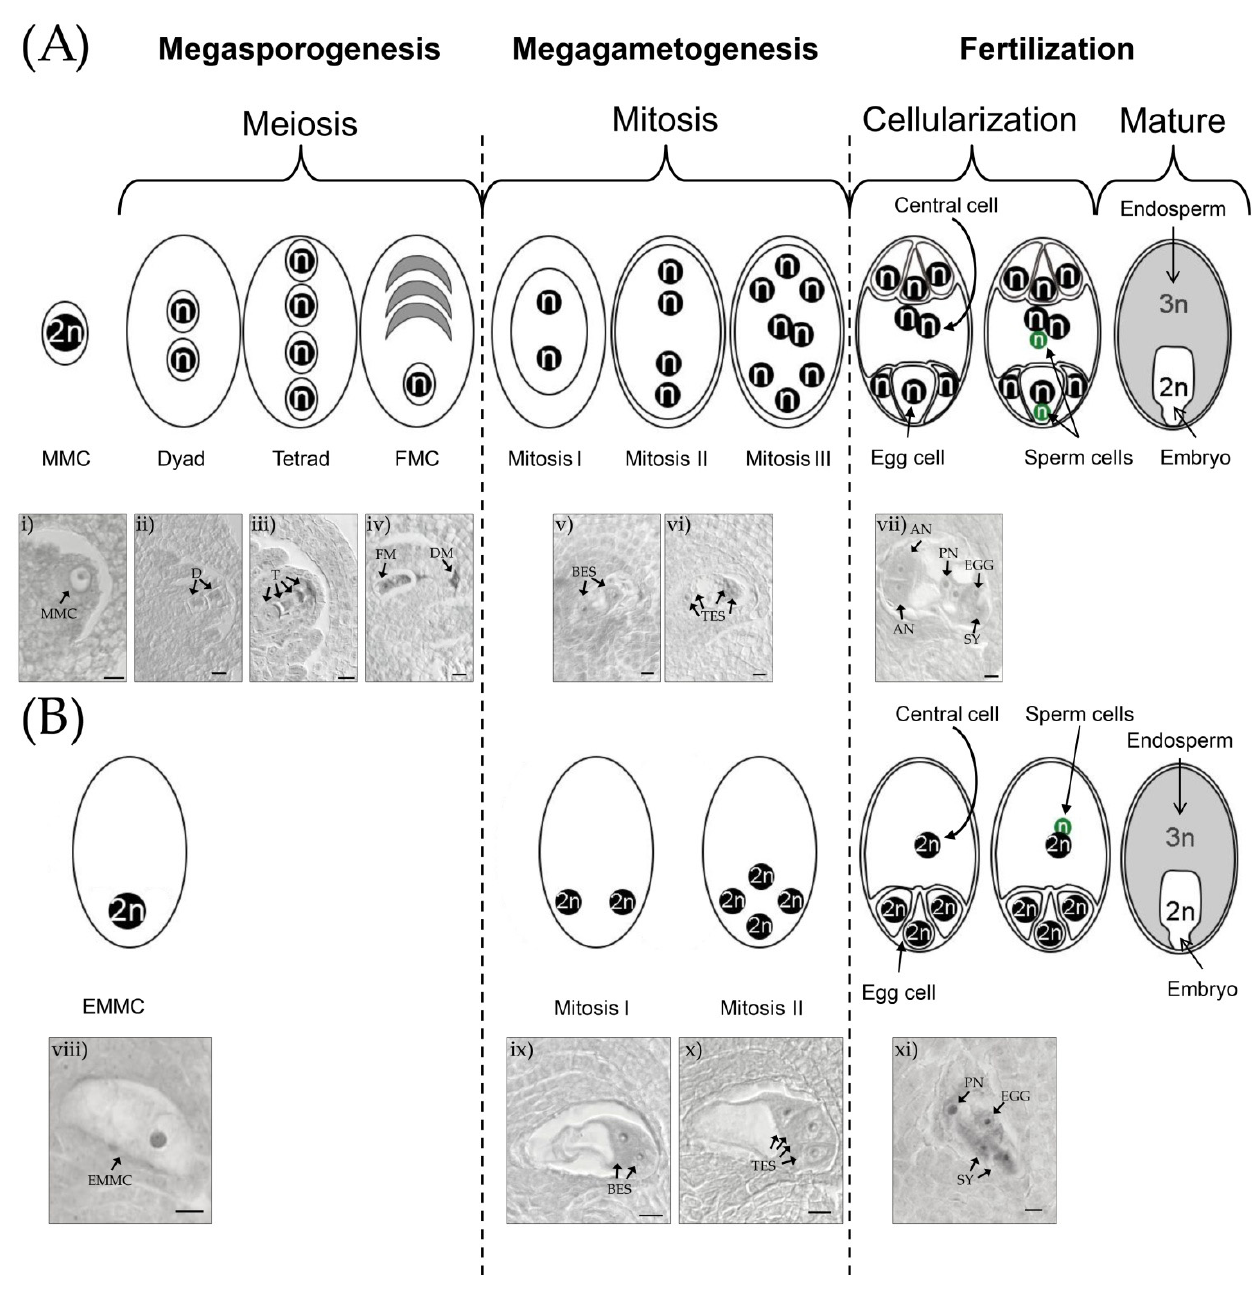
Figure 1. Scheme and safranin-fast green-stained sections of E. curvula embryo sac development in ( A ) sexual and ( B ) diplosporous apomictic (Eragrostis type) plants. Note in ( B ) the lack of meiosis during megasporogenesis, the absence of one round of mitosis in megagametogenesis, the fertilization of the polar nucleus (pseudogamy), and the formation of the embryo without fertilization (parthenogenesis). The scale bar equals 10 µm. ( A ) Sexual pathway (i) megaspore mother cell (MMC), (ii) meiosis I showing the dyad (D), (iii) meiosis II with the four cells in a linear tetrad, (iv) functional megaspore (FM) and degenerated megaspores (DM), (v) binucleated embryo sac (BEC) derived from mitosis I, (vi) tetranucleated embryo sac (TEC) from mitosis II, and (vii) embryo sac with antipodal cells (AN), polar nuclei (PN), egg cell (EGG), and one out of two synergid cells (SY). ( B ) Eragrostis type diplosporous apomixis, (viii) elongated megaspore mother cell (EMMC), (ix) binucleated embryo sac (BES) derived from mitosis I with nuclei at the micropylar pole, (x) tetranucleated embryo sac (TES) from mitosis II with nuclei at the micropylar pole, and (xi) embryo sac with polar nucleus (PN), egg cell (EGG), and synergid cells (SY).